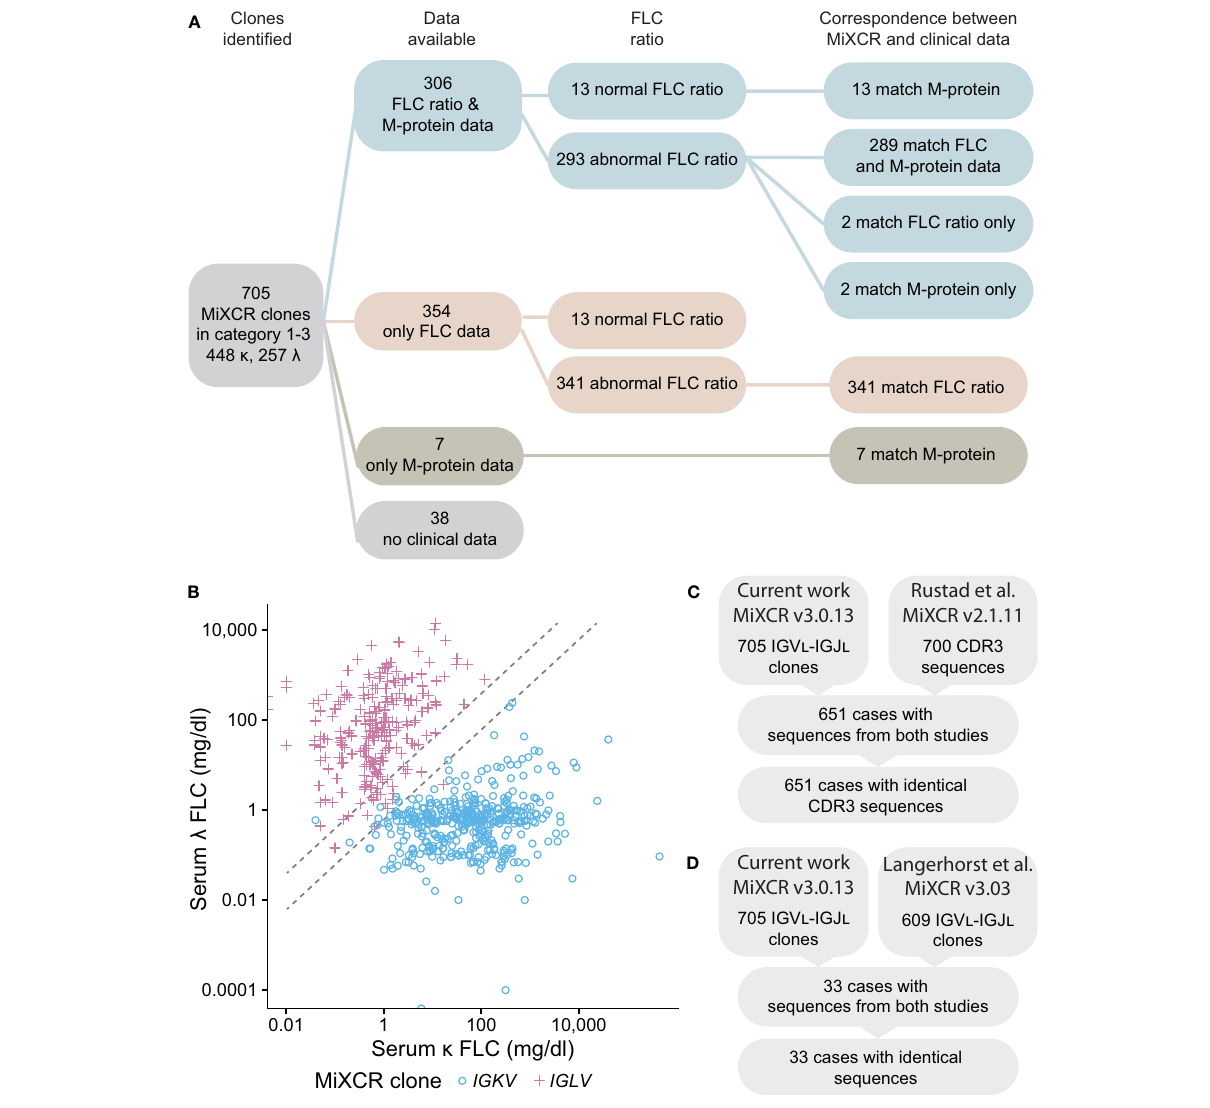
FIGURE 8 IGV L -IGJ L clones identi fi ed by MiXCR are consistent with clinical free LC ratios and previously determined sequences. (A) Work fl ow showing the number of samples available for comparison. Matching sequences are those where the IGK or IGL locus assigned by MiXCR is the same as that indicated by the clinical data. Only the identity of LC determined by immuno fi xation is shown for the M-protein data; of 313 samples with available M-protein results, 253 had complete immunoglobulin (data not shown). (B) Comparison of the k to l serum FLC ratio calculated from the CoMMpass clinical data with the identity of the clonal LC identi fi ed by MiXCR. IGKV and IGLV clones are shown as blue circles and pink crosses, respectively. Dashed lines demark the boundaries of normal k to l serum ratios. If the k to l serum ratio is >1.65 or <0.26, we would expect the most frequent MiXCR clone to be derived from IGKV or IGLV , respectively. (C) CDR3 sequences from Categories 1-3 determined in this work are identical to those previously determined by Rustad et al. (23). (D) IGV L -IGJ L sequences from Categories 1-3 determined in this work are identical to those previously determined by Langerhorst et al. (24). Only a representative example of sequences determined by Langerhorst et al. was available for